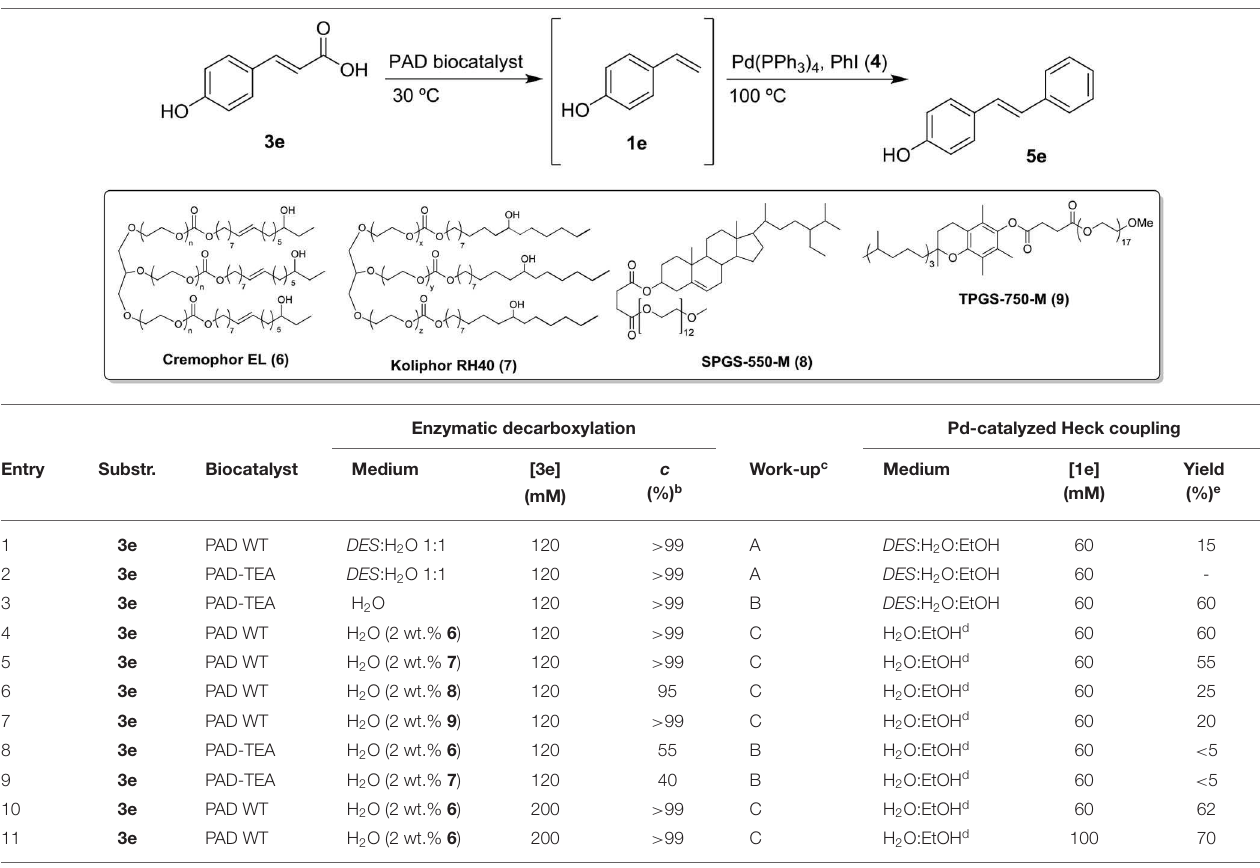
TABLE 3 | Strategies for the one-pot sequential enzymatic decarboxylation/Pd-catalyzed Heck coupling of p -hydroxycinnamic acid ( 3e ) in non-conventional media a